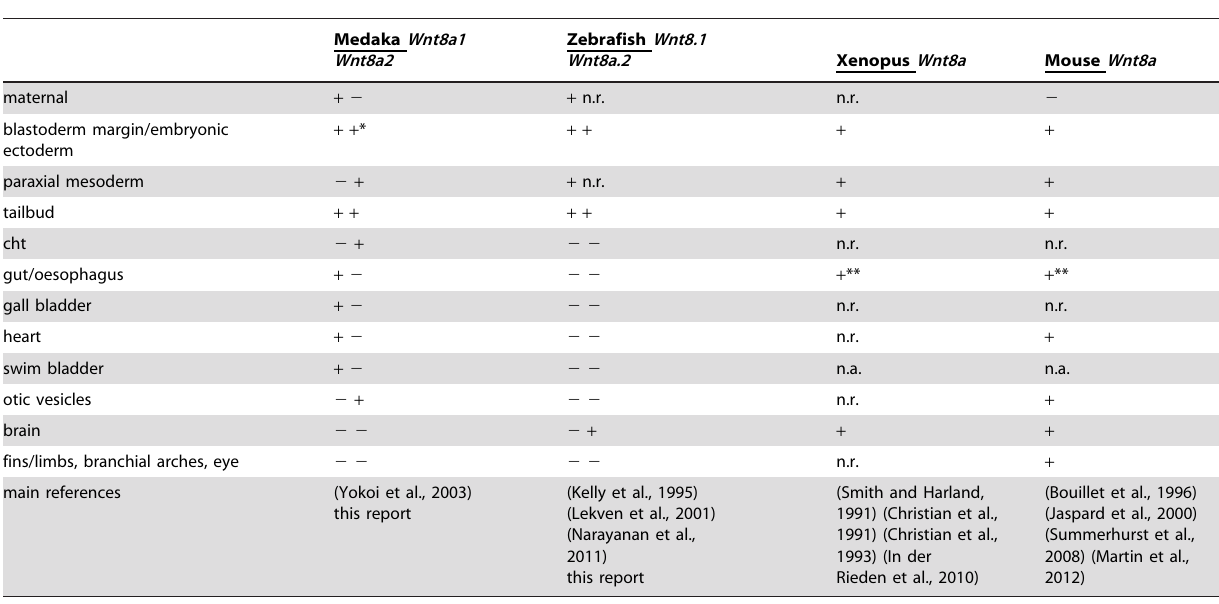
Table 1. Sites of Wnt8a gene expression in medaka, zebrafish, Xenopus and